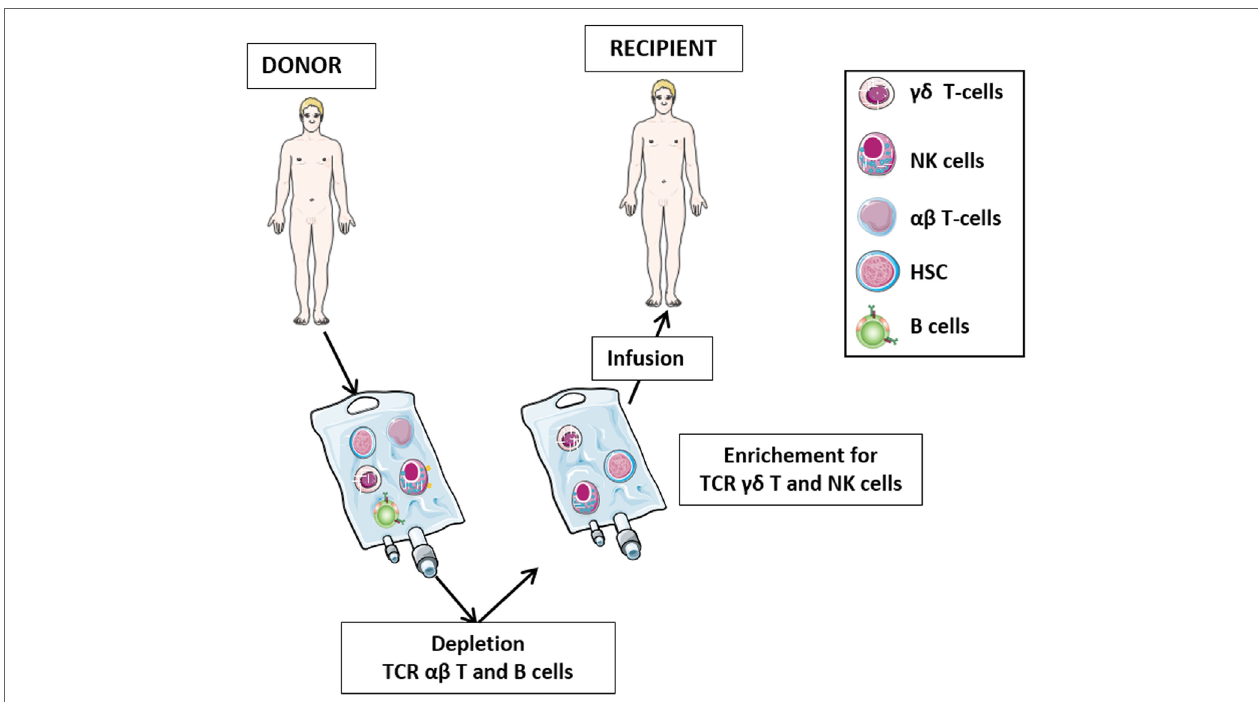
FiGURe 2 | The protocol of T-cell receptor (TCR) αβ T-cell and B-cell depletion recently developed in haplo-HSC transplantation. The protocol for haplo-HSCT allows infusion of donor HSC, together with high number of γδ T lymphocytes and NK cells. This novel strategy permits, during the early posttransplant period (6–8 weeks), a better control of leukemia cells escaping the preparative regimen, thus preventing disease relapses. In this transplantation setting, in addition to γδ T-cells and NK cells developing late from donor HSC, these promptly available effectors transferred with the graft may immediately exert their graft-versus-leukemia effect and contribute to the control of